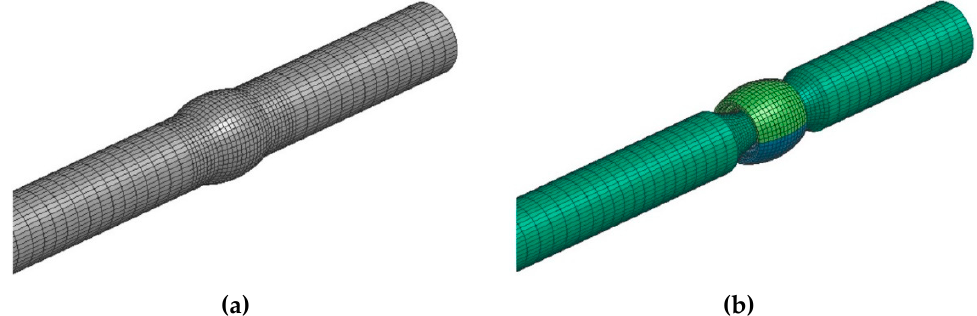
Figure 23. ( a ) The 3D computational mesh model of the formed welded joint; and ( b ) the volume transparent description of the removed material with the aim to produce the sample for evaluating the multiaxial fatigue of the welded joint.